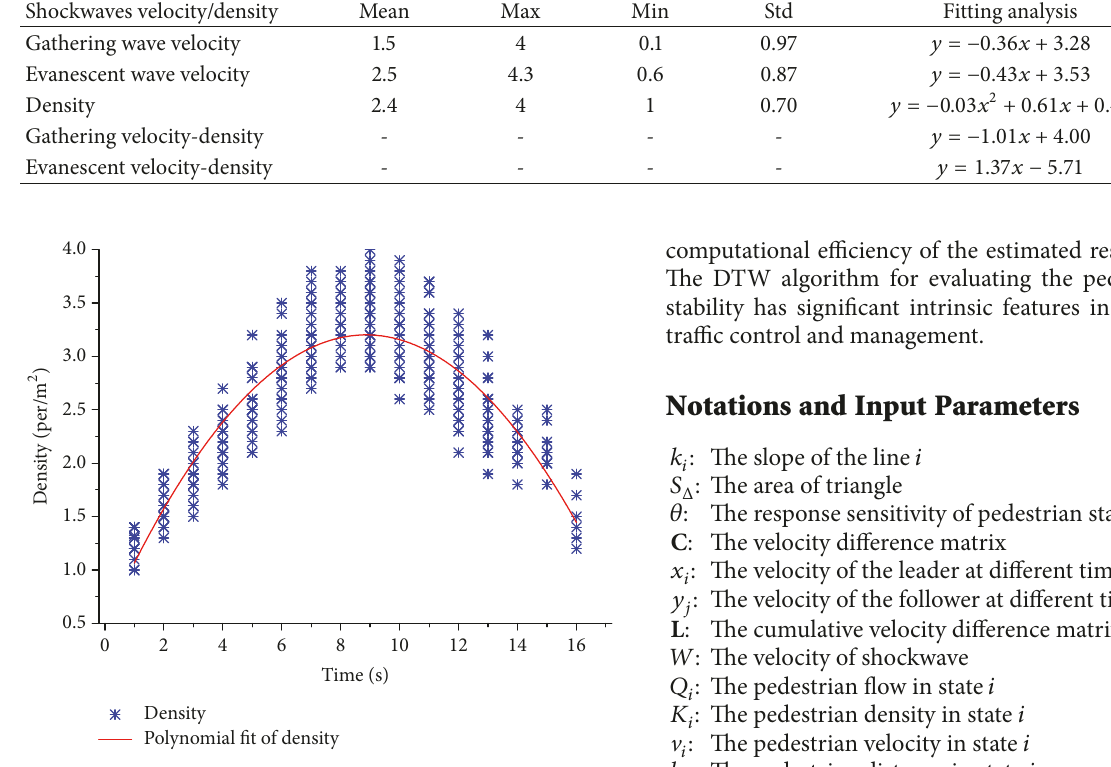
Figure 8: Density for 25 times of pedestrian flow.